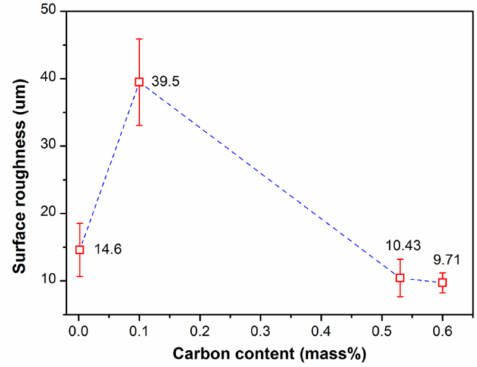
Figure 8. Relationship between the surface roughness and carbon